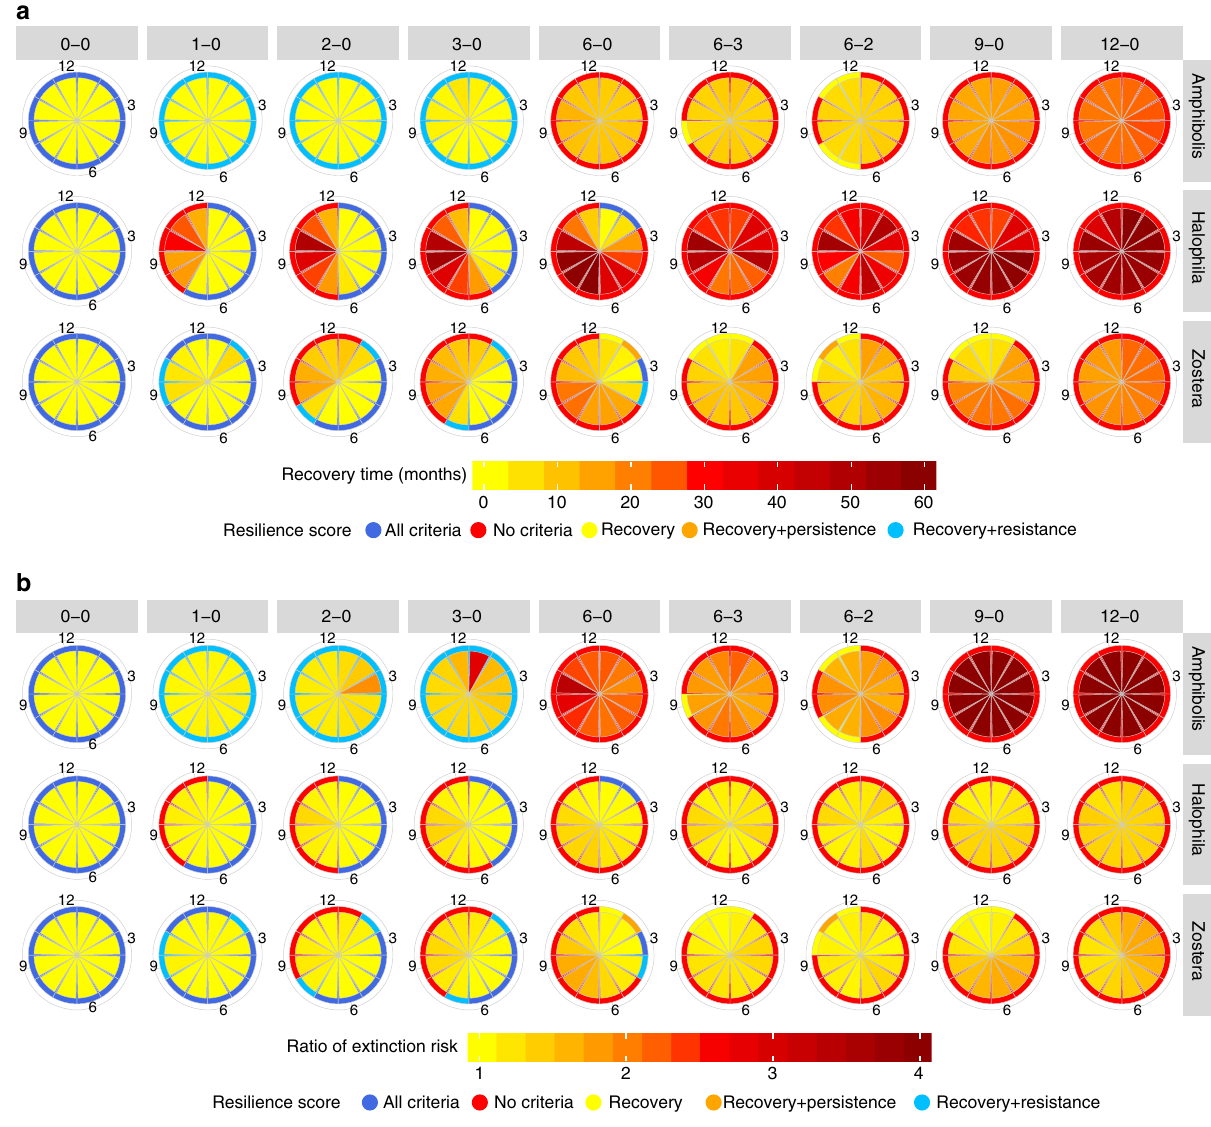
Fig. 1 Responses of seagrass populations at three sites for eight dredging and one control scenario. The sites (rows) are: persistent Amphibolis in Jurien Bay, Australia (top row), colonising Halophila at Hay Point, Australia (middle row) and opportunistic Zostera in Puget Sound, USA (bottom row). Dredging scenarios (columns), all result in the absence of saturating light. Each pie slice re fl ects the time to recovery ( a ) and the ratio of the extinction risk compared to baseline ( b ) for dredging starting in that month. Months are indicated by numerals in the outer ring, where 12 denotes December. All results are aligned to Austral summers to enable seasonal comparisons. The outer coloured edge of each pie reports a resilience criteria score (see